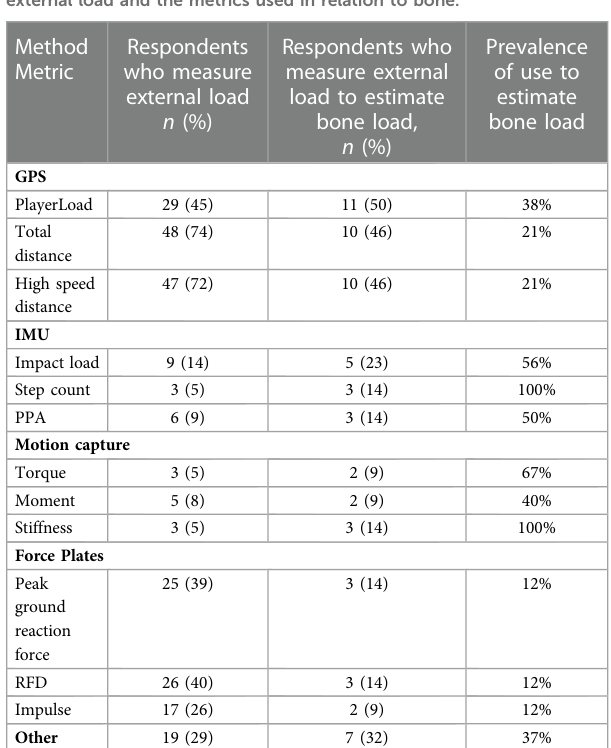
TABLE 2 Support staff responses to the metrics used when measuring external load and the metrics used in relation to bone.